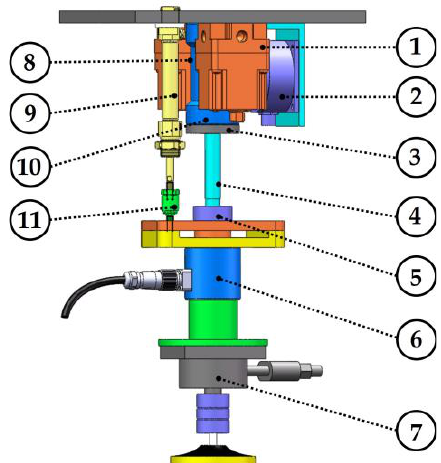
Figure 1. Force-controlled actuator structure. 1 — Electrical proportional valve (a), 2 — Tilt sensor, 3 — Ball spline flange, 4 — Ball spline shaft, 5 — Expansion sleeve, 6 — Force Sensor, 7 — Polishing Tool, 8 — Electrical proportional valve (b), 9 — Cylinder, 10 — Guiding device, 11 — Floating joint.